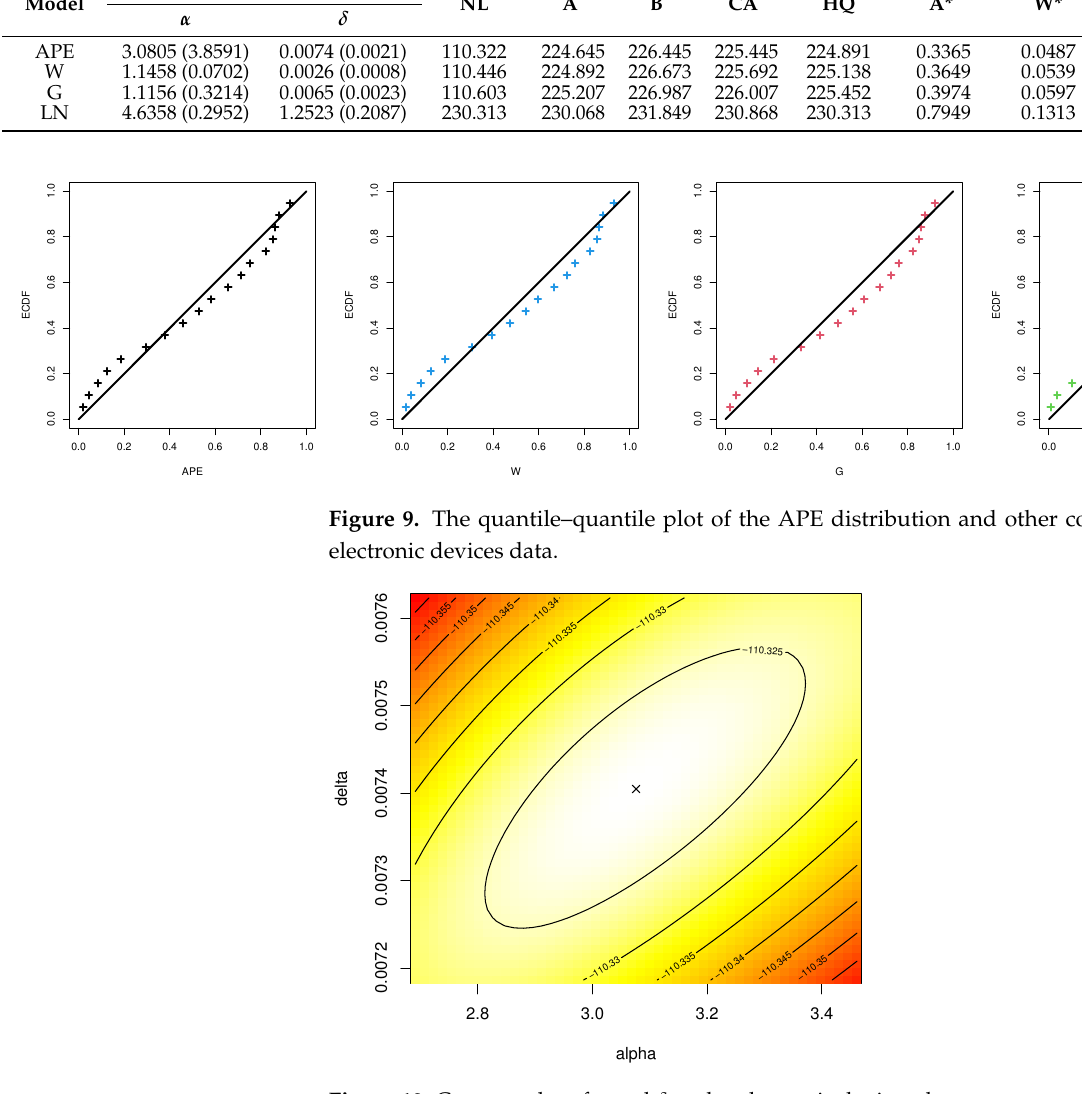
Figure 10. Contour plot of α and δ under electronic devices